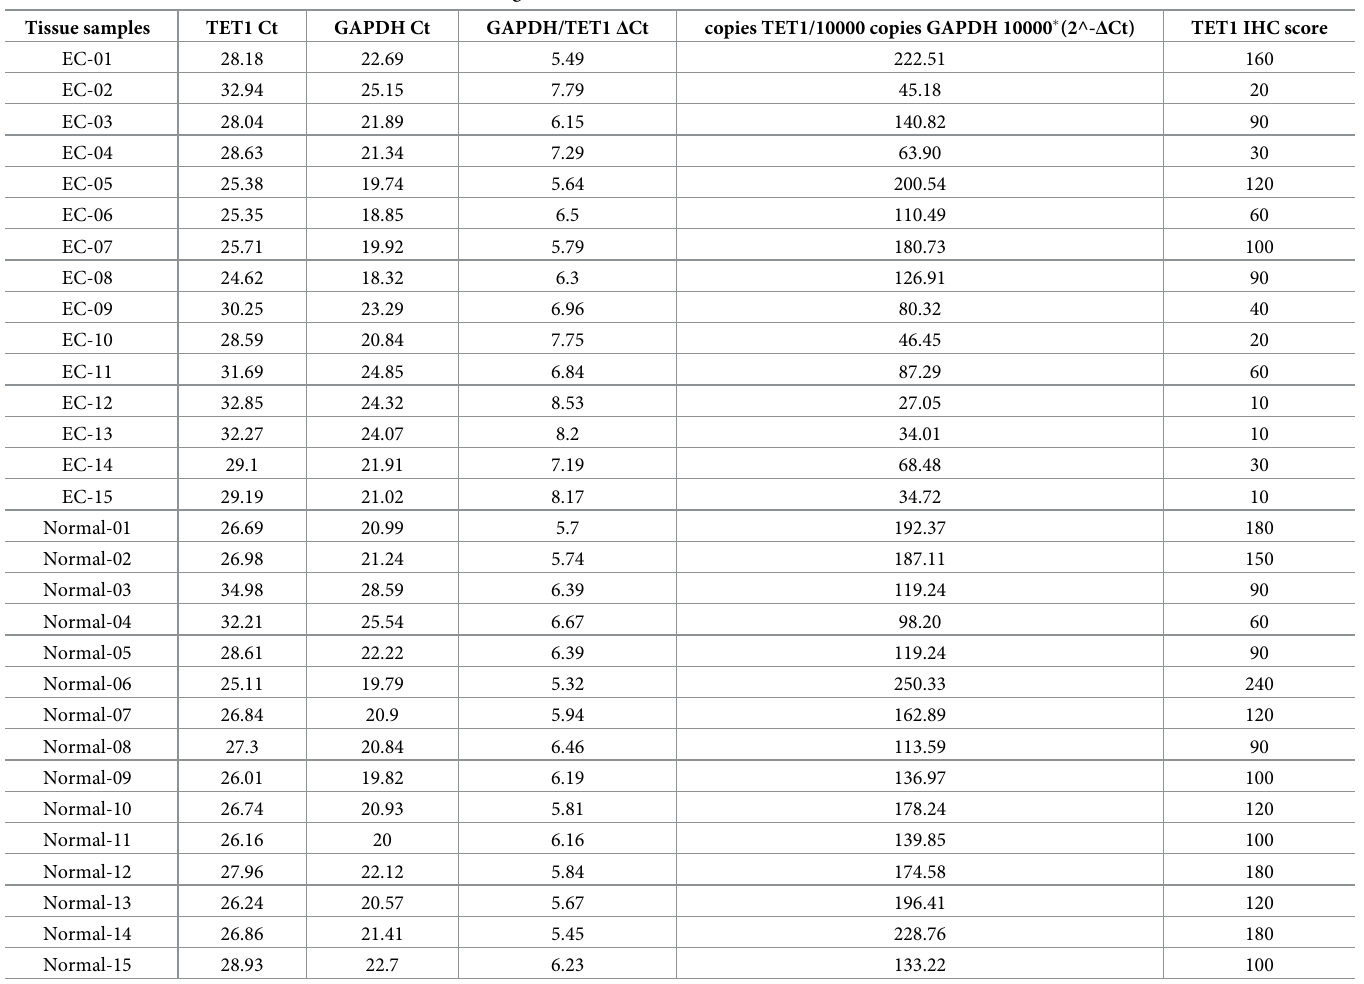
Table 2. The real time RT-PCR results of TET1 and GAPDH